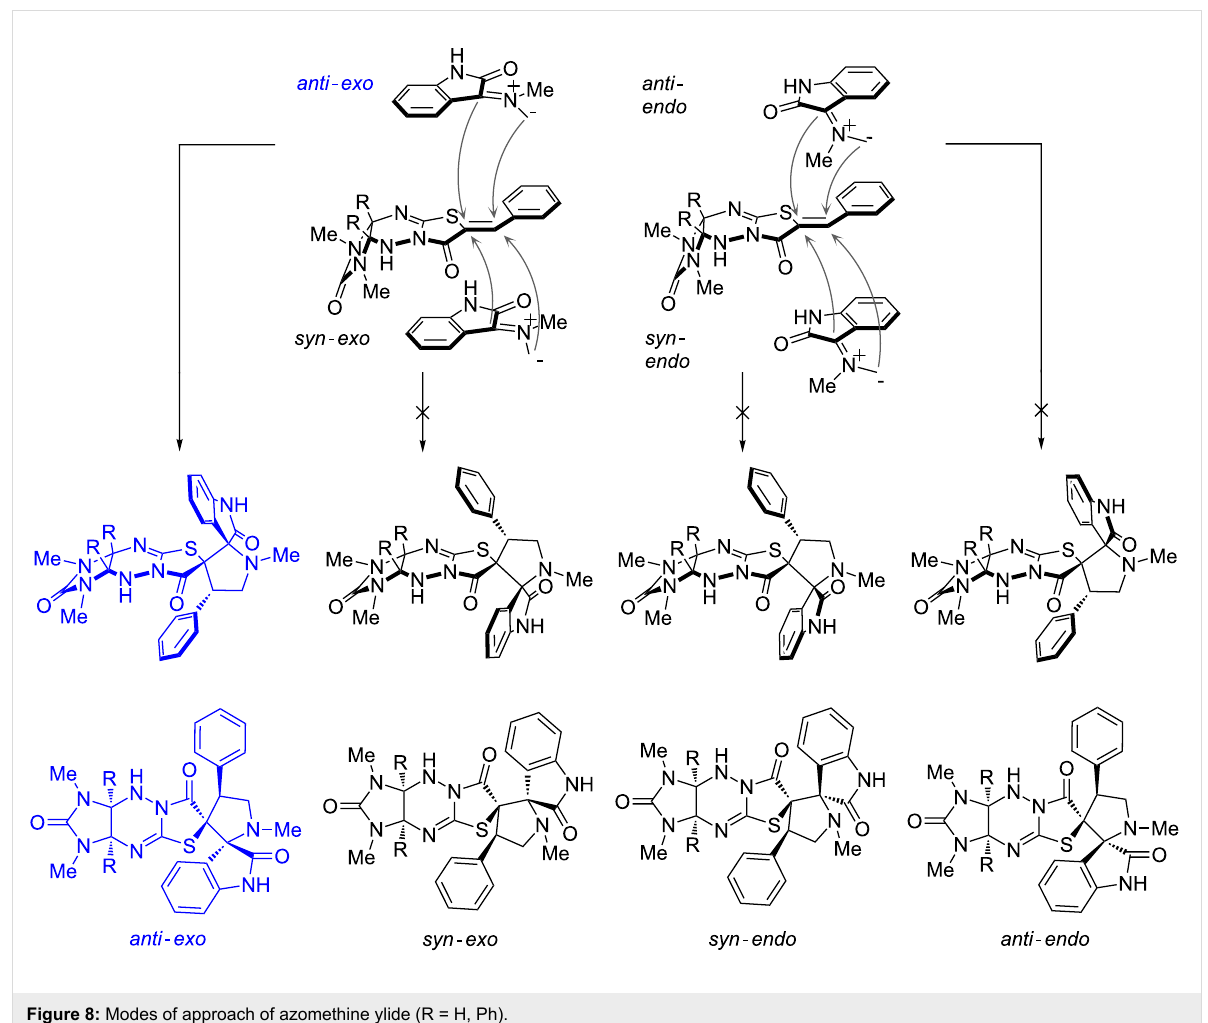
Figure 8: Modes of approach of azomethine ylide (R = H, Ph).